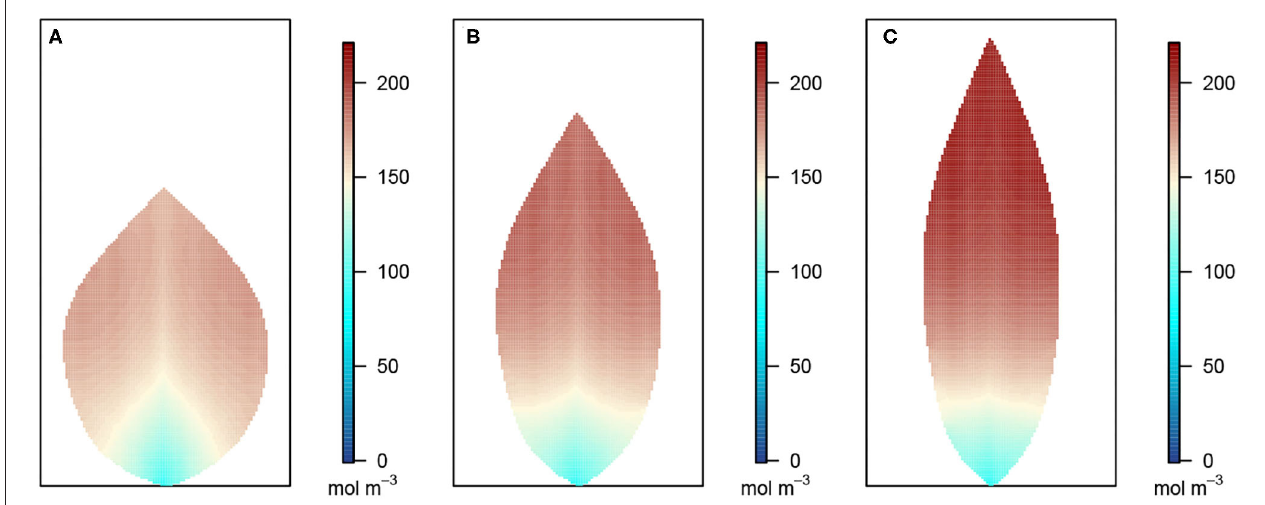
FIGURE 5 | Leaf area distribution of sucrose concentration in the phloem network. (A) Wide leaf, (B) reference leaf, and (C) narrow leaf. Details as in Figure 3